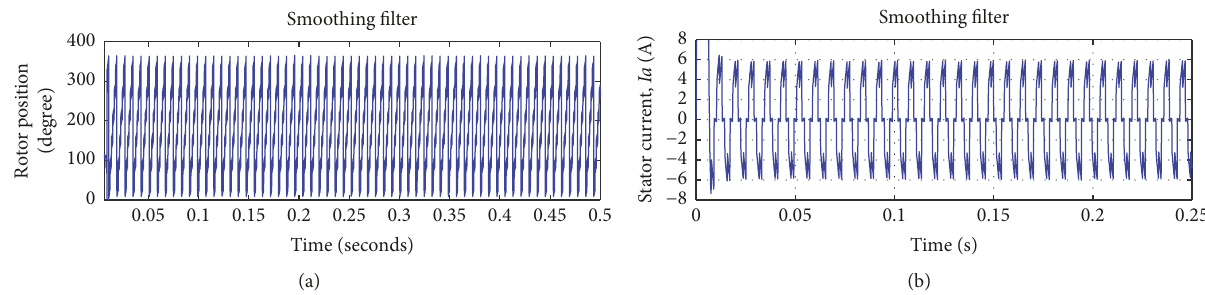
Smoothing filter